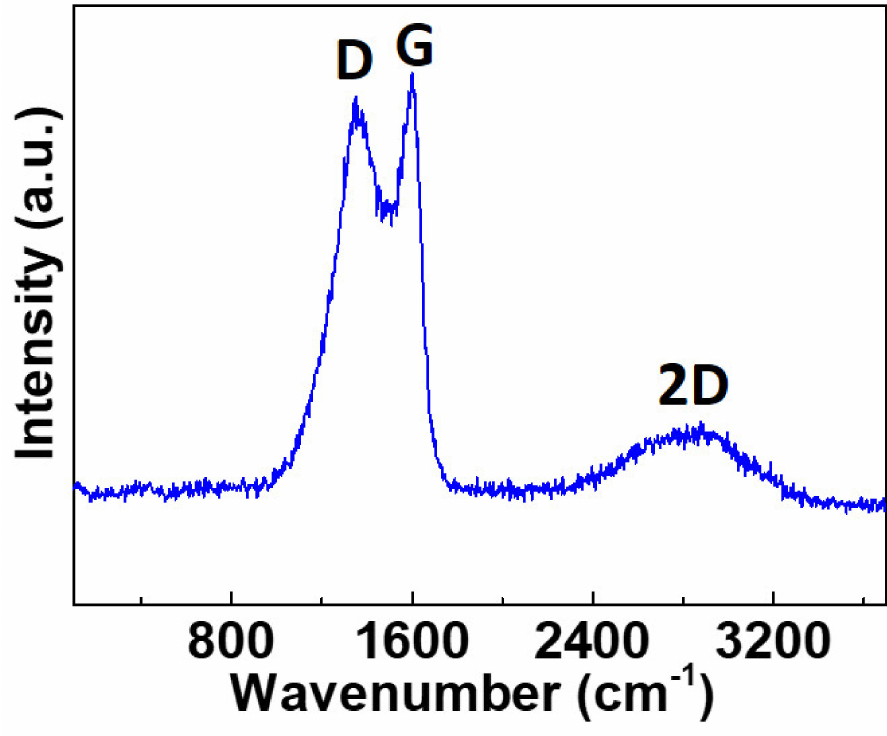
Figure 3. Raman spectra of the N-doped CH_K carbons.